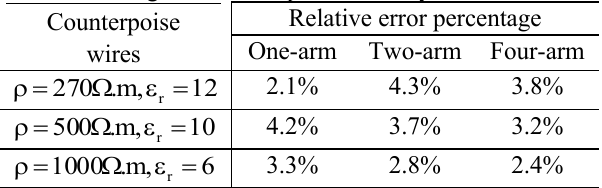
Table 2: Relative error percentage for computing effective length of counterpoise wires by two methods .